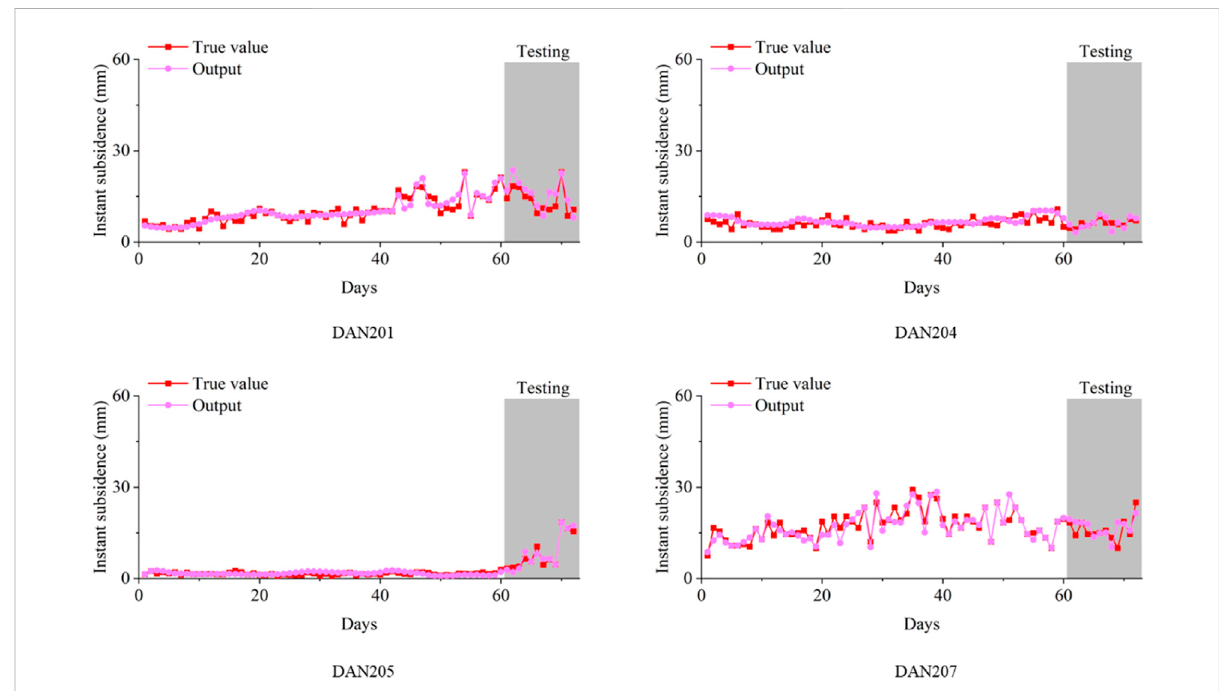
FIGURE 4 12-day ahead prediction of instantaneous subsidence.